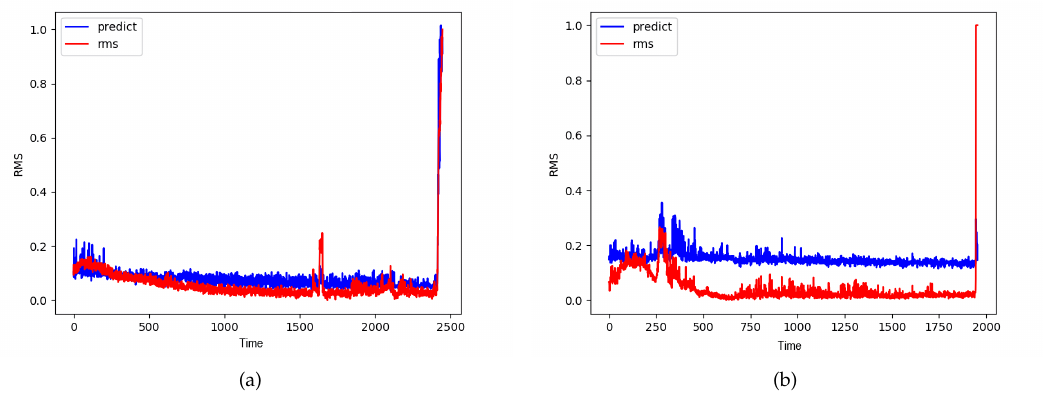
Figure 14. RMS values for each bearing in the FEMTO dataset, ( a ) Condition 1, ( b ) Condition 2.